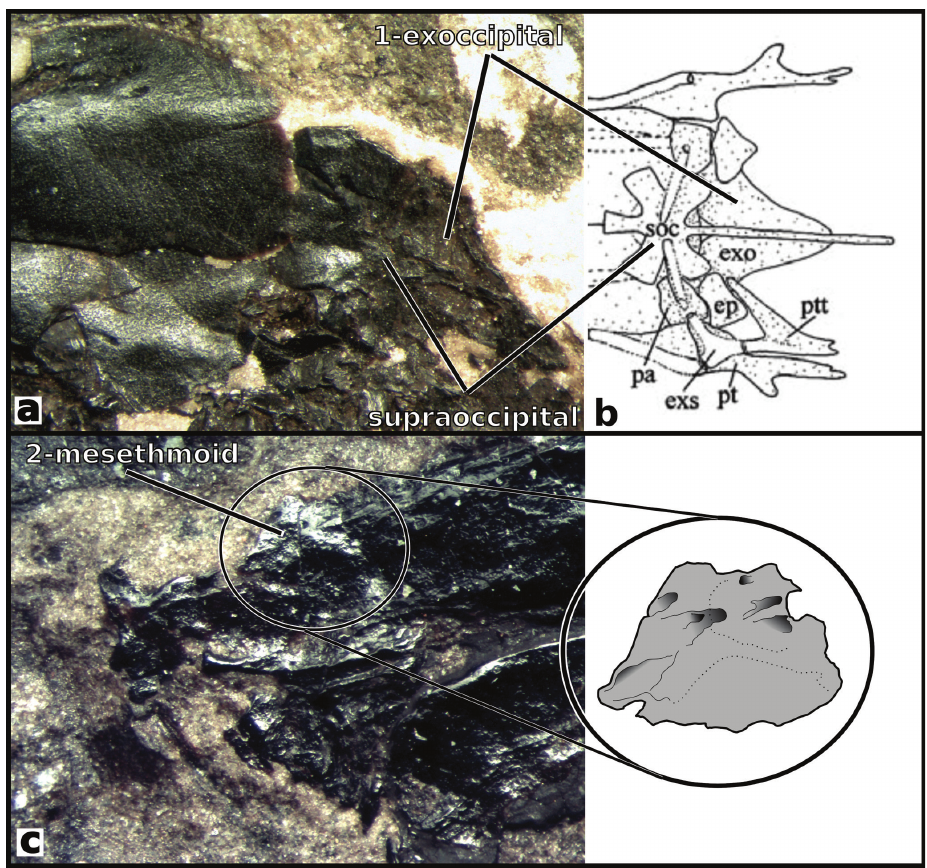
Fig. 8 . a. Dorsal view of the posterior portion of skull in Dastilbe moraesi (CPUFMT 732.7 mm TFL) and b. Chanos chanos (modified from Poyato-Ariza et al ., 2010). c. Dorsal view of the anterior portion of skull in Dastilbe moraesi (CPUFMT 735, 26.4 mm SL). Synapomorphies of Chanini observed are: 1- exoccipitals with a posterior concave-convex border, with a projection above basioccipital. 2- large mesethmoid, with broad posterolateral wing-like